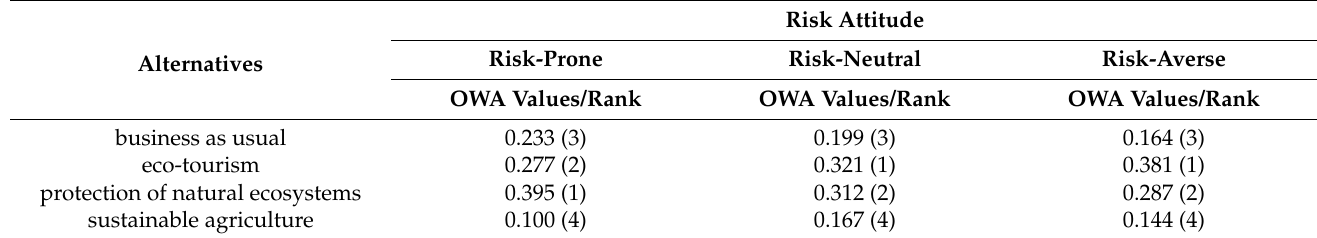
Table 10. OWA values and the final ranking of alternatives for different risk